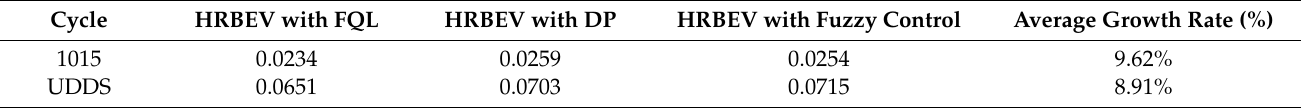
Table 4. The amount of electricity